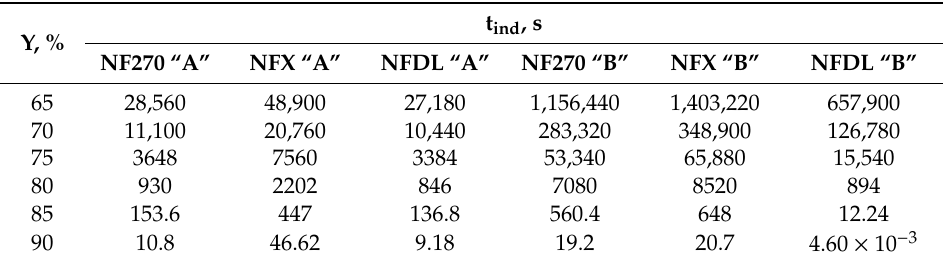
Table 3. Induction time of calcium sulfate dihydrate during the NF process at the retentate outlet (0.916 m of module length)—e ff ect of permeate recovery Y, mine water (“A”: 0.384 g / L as Cl − , 1.02 g / L as SO 42 − , 0.107 g / L as Na + , 0.142 g / L as Mg 2 + , 0.312 g / L as Ca 2 + ; “B”: 33.2 g / L as Cl − , 0.937 g / L as SO 42 − , 19.5 g / L as Na + , 0.990 g / L as Mg 2 + , 0.771 g / L as Ca 2 + ) and nanofiltration membrane type.